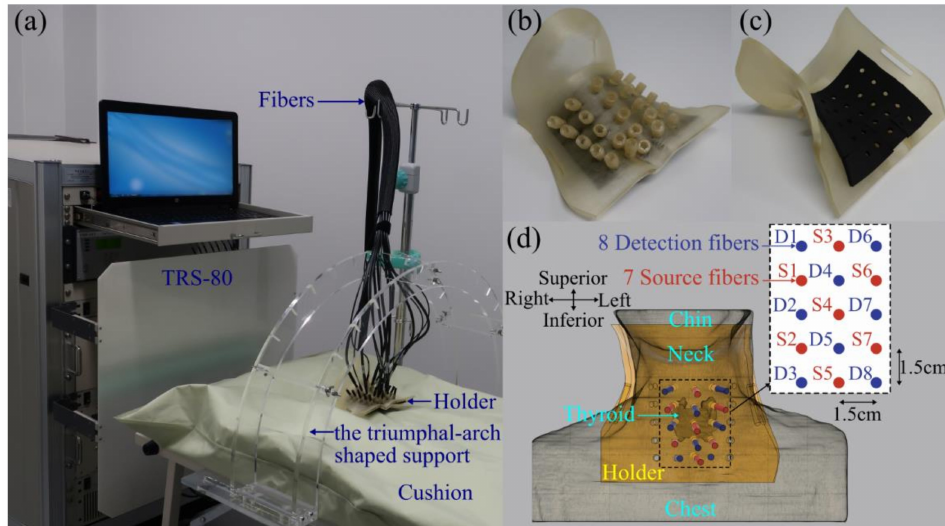
Figure 1. ( a ) Measurement setting; ( b ) optical fiber holder (front); ( c ) optical fiber holder (back); ( d ) schematic of the figure, which shows positions of the holder, fibers, and thyroid. Source fibers are marked in red, and detection fibers are shown in